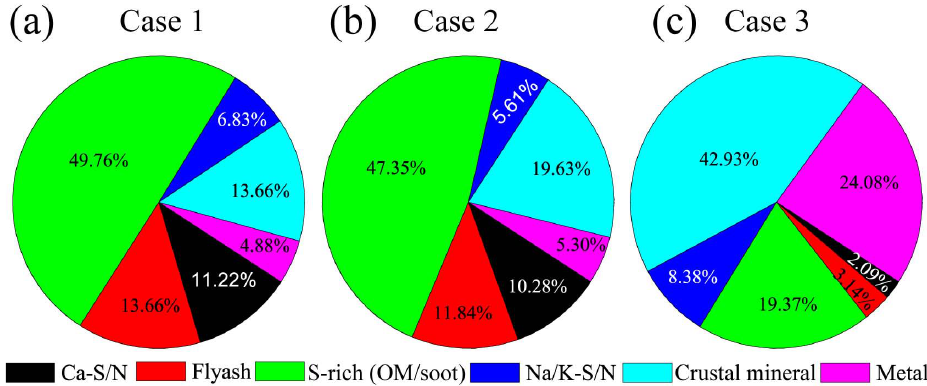
Fig. 6. Number fractions of particle types measured by the TEM/EDS. (a) 205 individual aerosol particles were analyzed in phase-I; 38% of S-rich particles were internally mixed with soot. (b) 321 individual aerosol particles were analyzed in phase-II; 83% of S-rich particles were internally mixed with soot. (c) 191 individual aerosol particles were analyzed in phase-III; 72% of S-rich particles were internally mixed with soot.